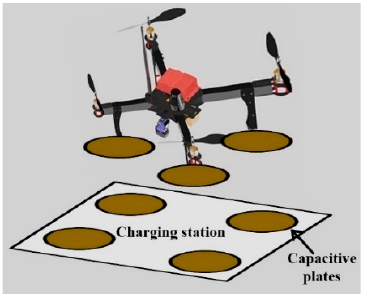
Figure 6. Drone charging using 8-plate coupling plates.